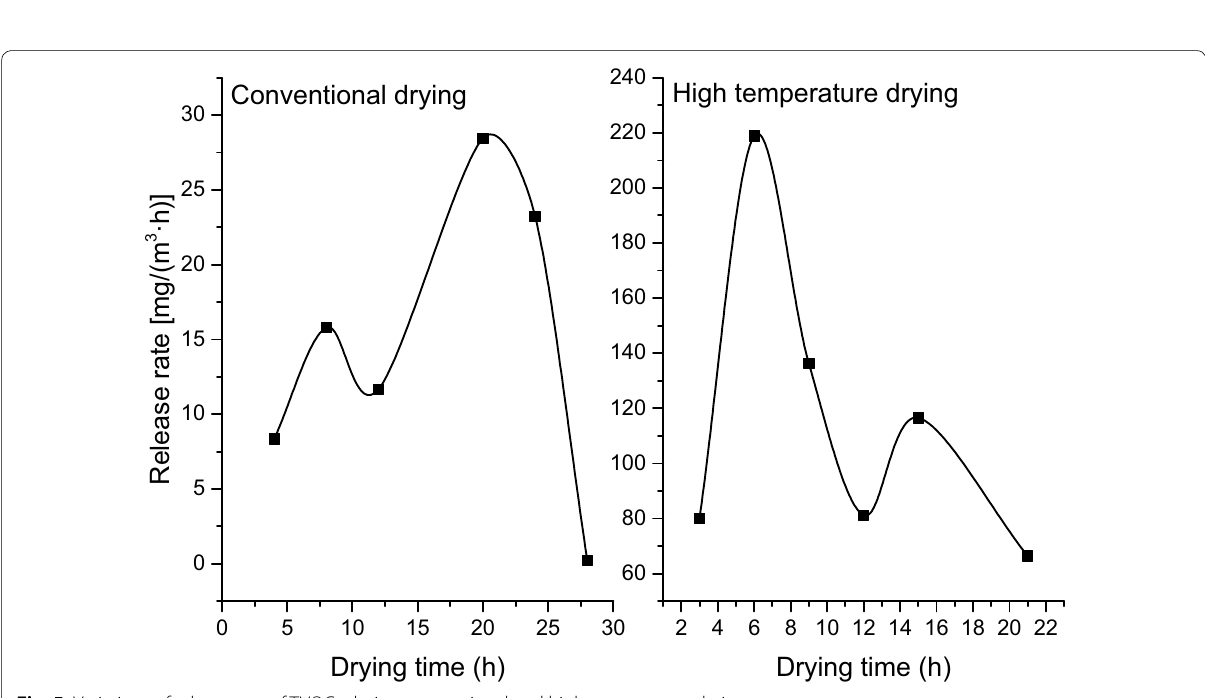
Fig. 5 Variations of release rate of TVOCs during conventional and high-temperature